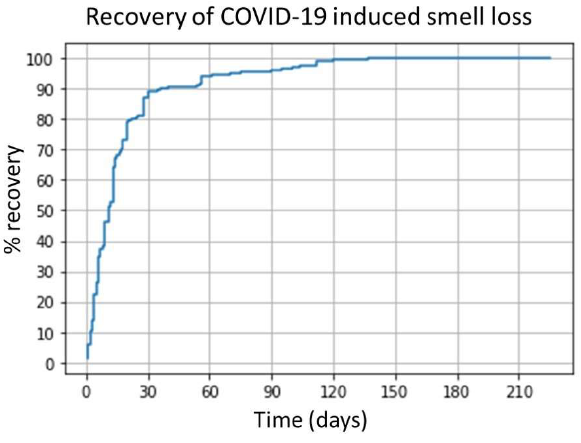
Figure 1. Recovery curve for smell loss, n = 207. Figure 1. recovery curve for smell loss, n = 207.